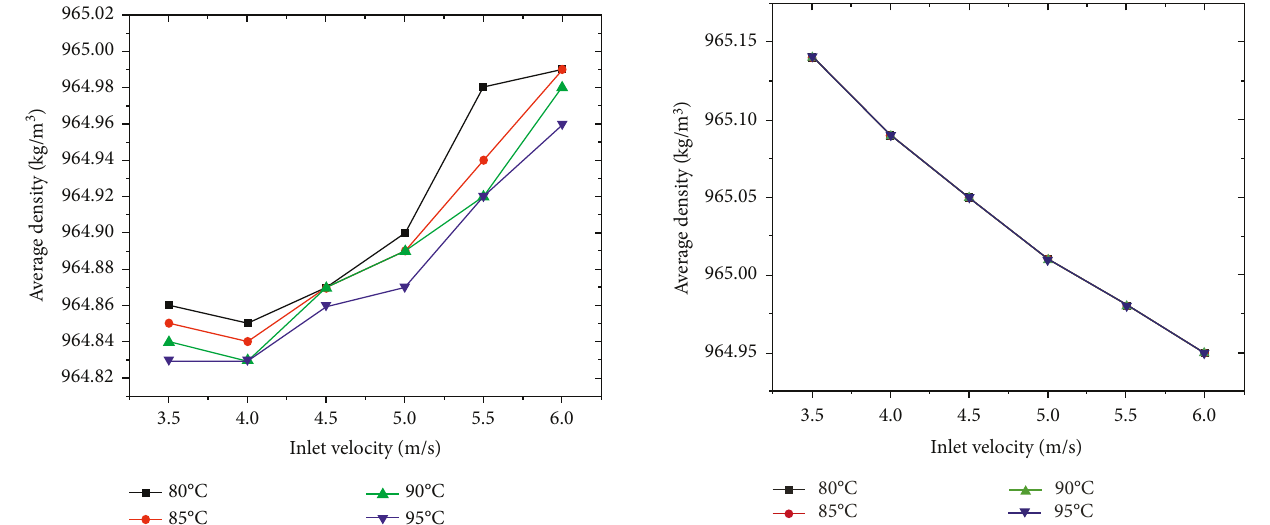
Figure 36: Inlet velocity and average density with temperature for 20% opening.